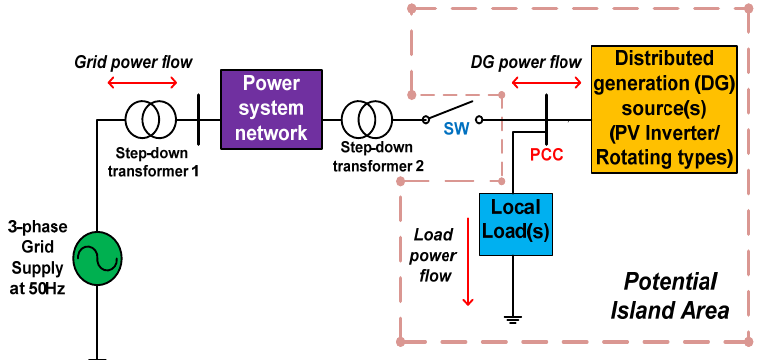
Figure 1. Unintentional island detection test circuit model as per IEEE 1547.1-2005 standard.